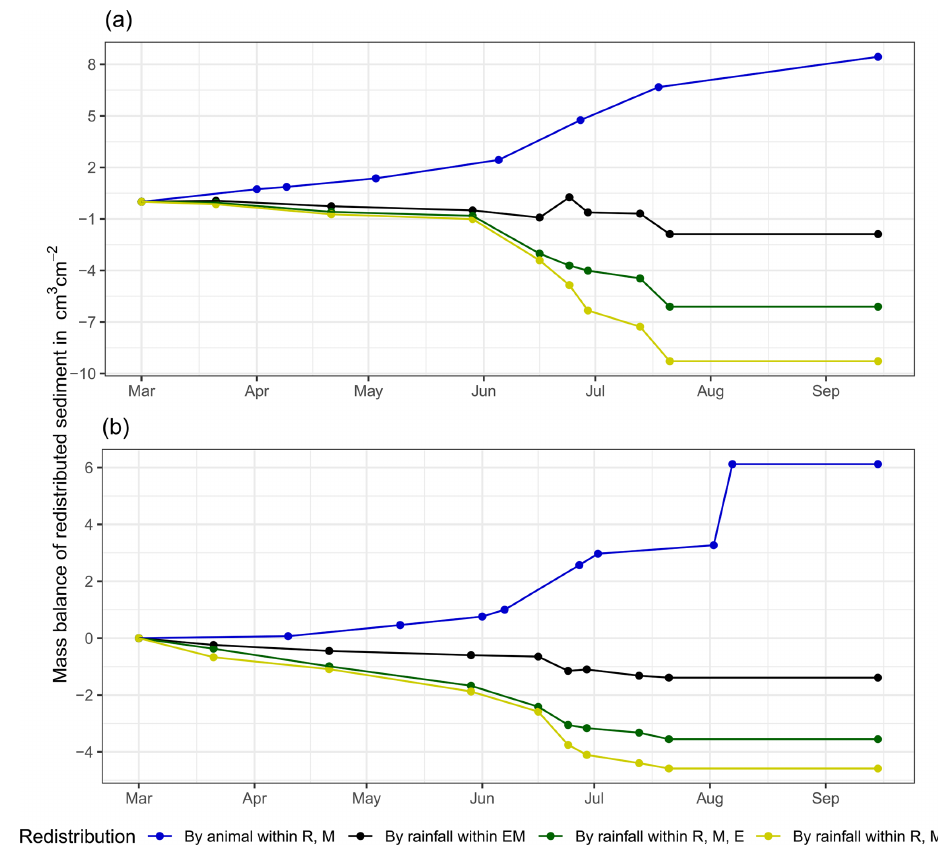
Figure 6. Examples of the cumulative volume of redistributed sediment within burrows and burrow-embedded areas caused by animal burrowing activity or rainfall in the Mediterranean climate zone of La Campana for the (a) north-facing upper hillslope and (b) south-facing lower hillslope. Positive values indicate sediment accumulation. Negative values indicate sediment erosion. E is the burrow entrance, M is the mound, R is the burrow roof, and EM is the burrow-embedded area. Cumulative volumes for all cameras are given in Fig.